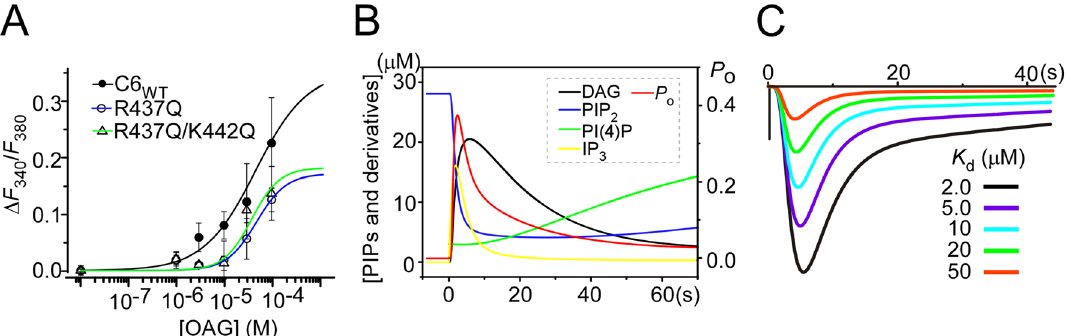
Figure 6. Dose–response to DAG and kinetic simulation. ( A ) Dose–response relationship for OAG in TRPC6- expressing cells obtained by Ba 2+ influx imaging using Fura-2 ( n = 12–25 for each data point). ( B ) The simulated time course of concentration of PIPs signaling products and open probability ( P o) of TRPC6 channels. ( C ) Current traces generated in a PIP 2 -DAG model simulation in which the dissociation constants for PIP 2 binding to TRPC6 channels were varied. Wild-type TRPC6 has ~ 2 µM of dissociation constants for PIP 2 binding 15 . The black scale bar indicates 0.5